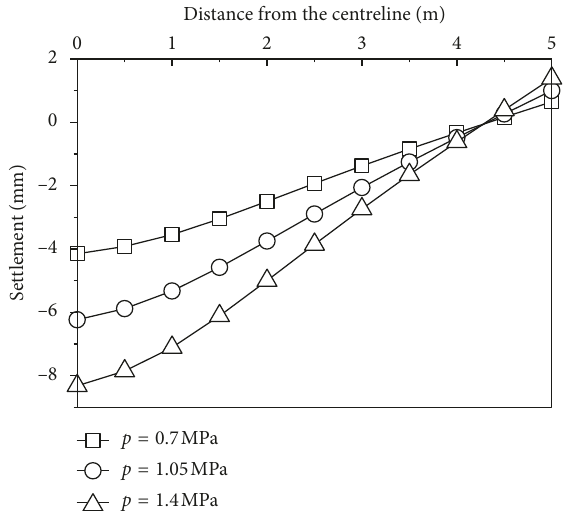
Figure 8: Settlement of the pavement with different axle (3) The surface settlement decreases with the increase of base modulus, base thickness, and distance away from the centerline, but increases with increasing traffic loads. The modulus of the roadbase was not the primary factor affecting the pavement settlement, if the base material meets the standard requirements.